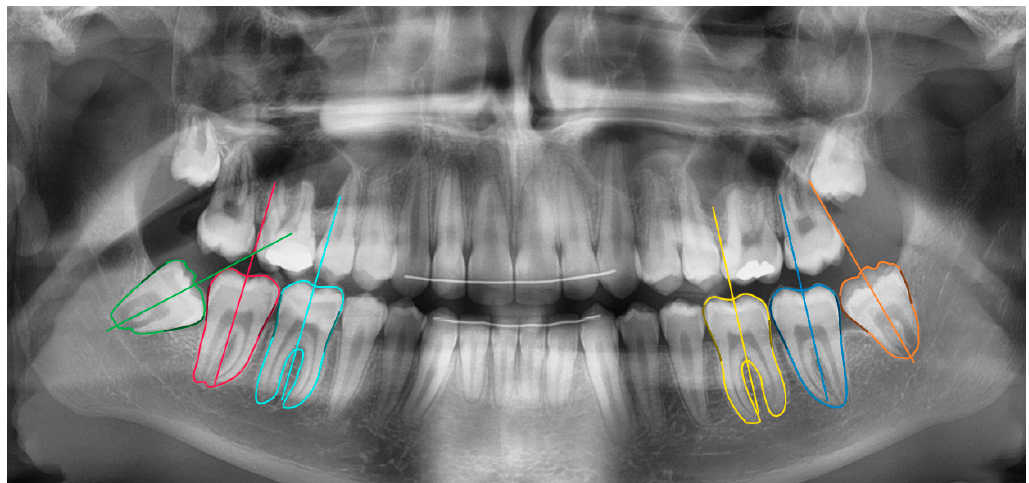
Figure 1. The network calculations were two-fold: six mandibular molar segmentation maps and orientation lines.